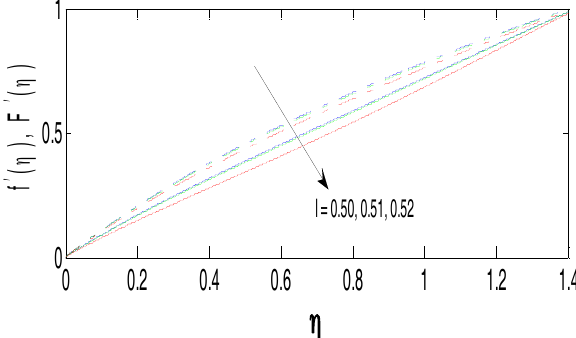
l = 0.50, 0.51, 0.52